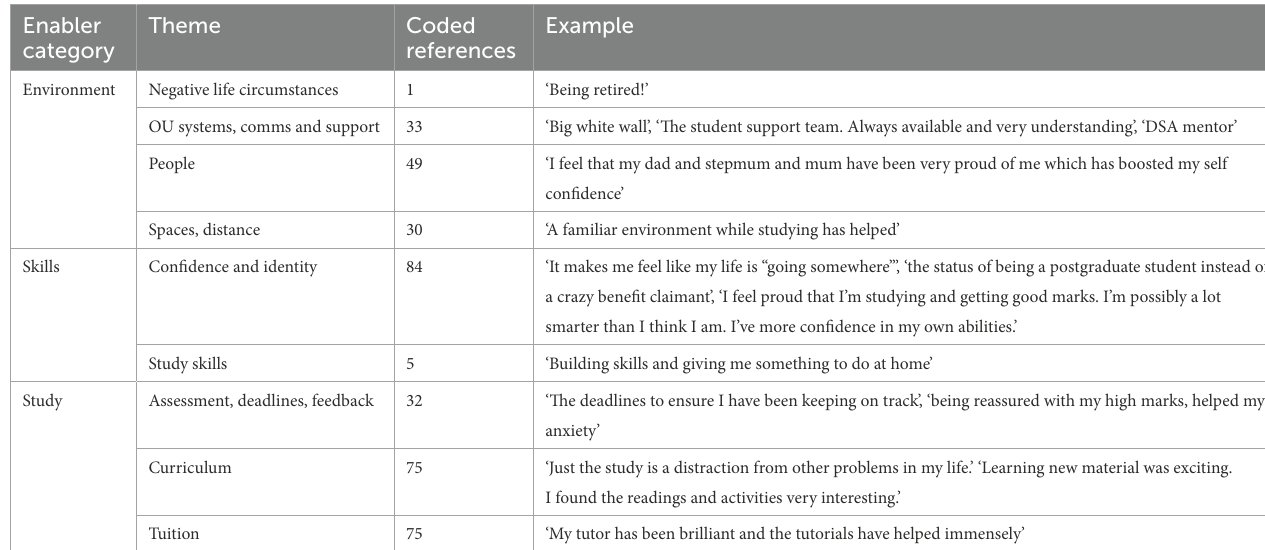
TABLE 5 Open comment references to